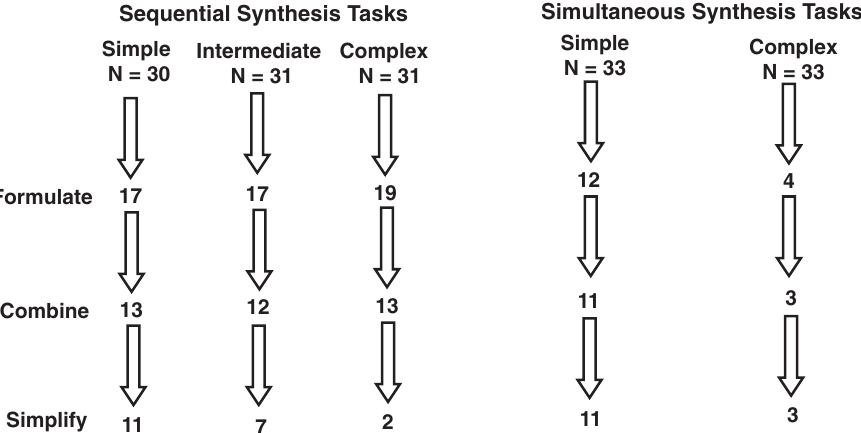
FIG. 7. Number of students formulating all the fundamental equations, combining the formulated equations and simplifying the combined equations for the sequential and simultaneous synthesis tasks with varying mathematical complexity.